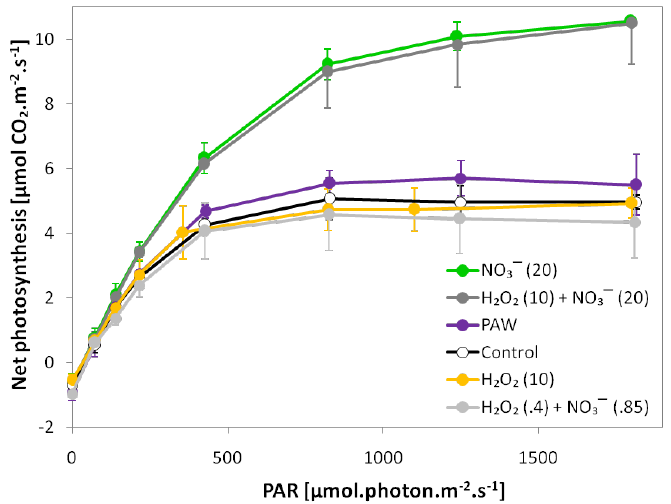
Figure 5. Net photosynthetic rate in above-ground parts of lettuce plants after 5 weeks of soil cultivation irrigated with the plasma activated water (PAW), solutions of various concentrations of H 2 O 2 (10 mM), NO 3 − (20 mM), H 2 O 2 + NO 3 − (0.4 mM + 0.85 mM, 10 mM + 20 mM), and control irrigated with tap water. The data are presented as mean values ± standard deviation from 3 independent repetitions.